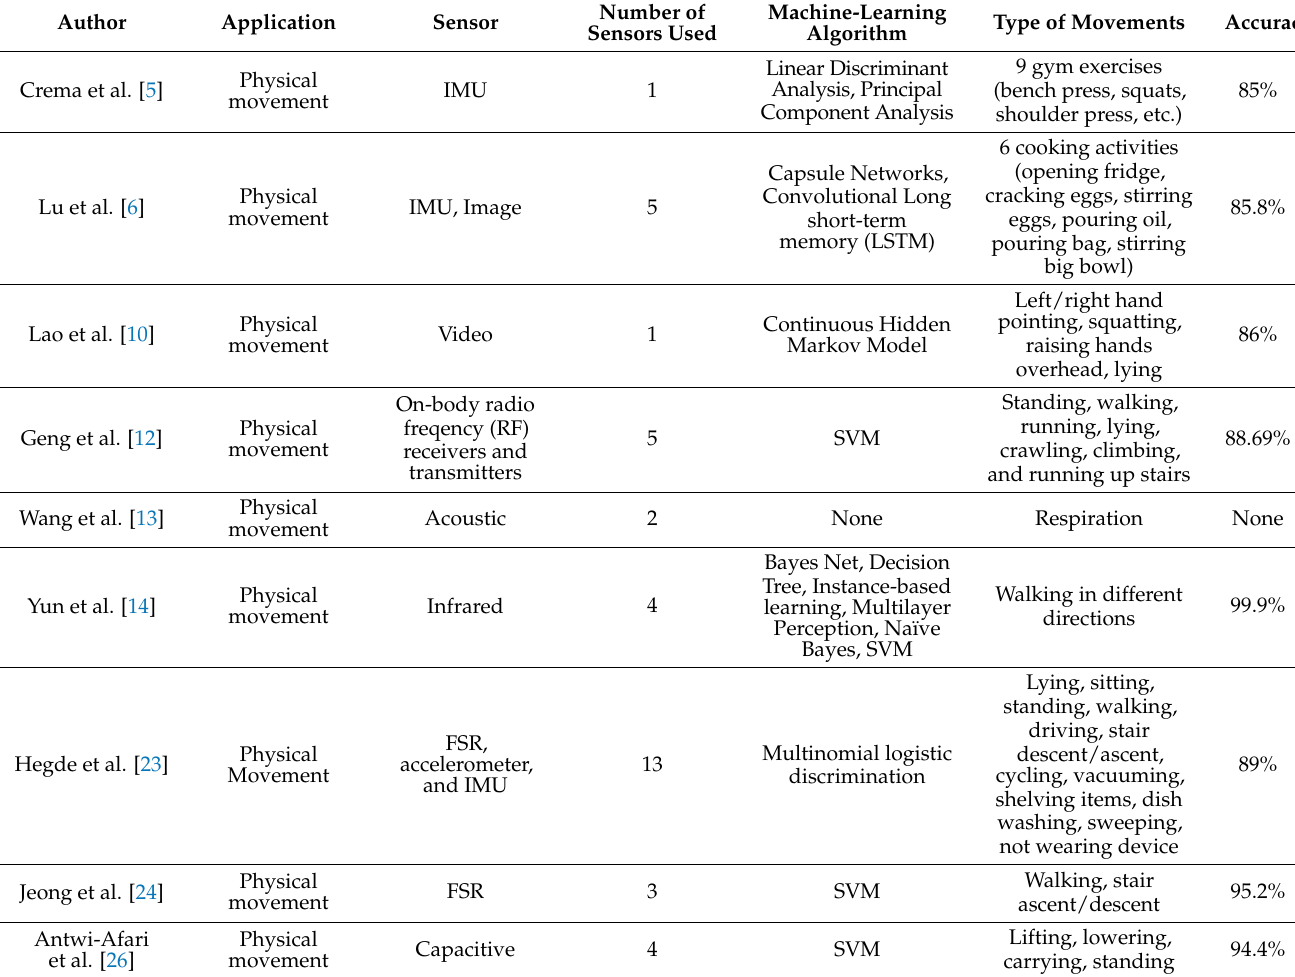
Table 1. Previous Studies for Human Movement